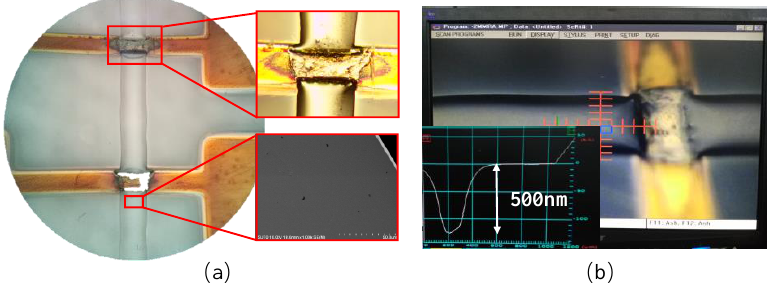
Figure 6. Sintering effect of hot-melt glass: ( a ) slurry morphology; ( b ) measuring diagram of step meter.